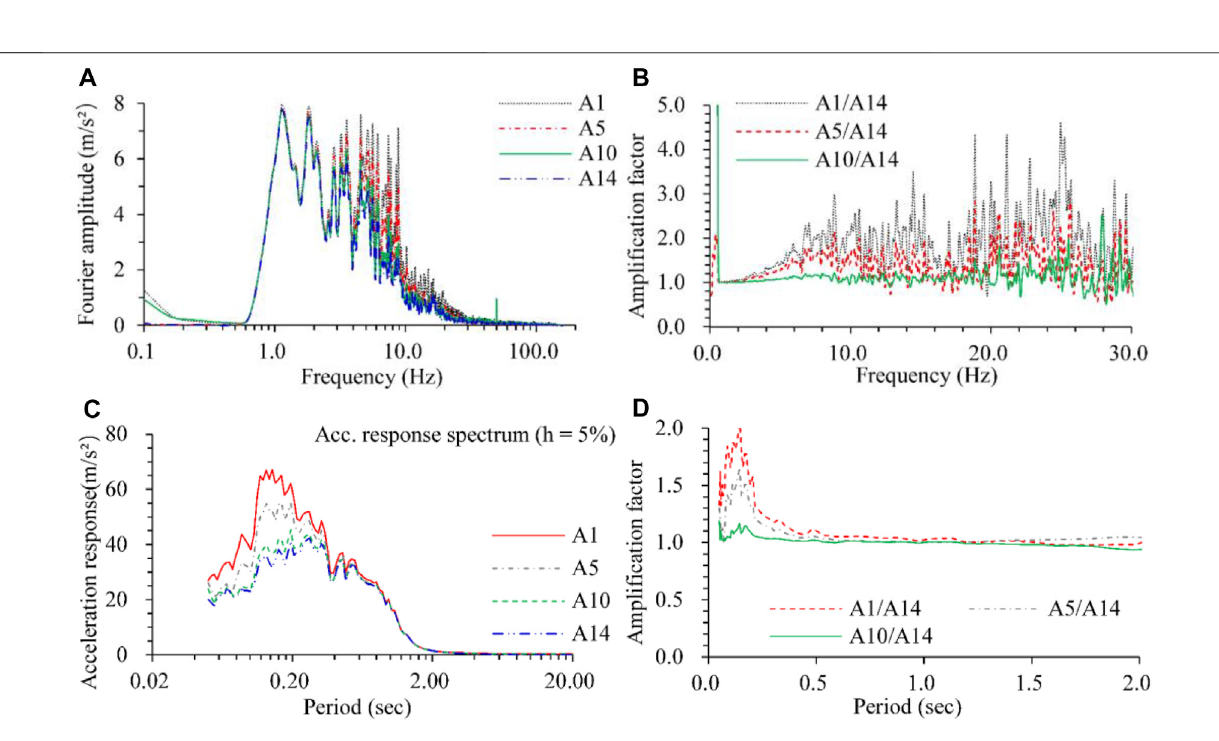
Frontiers in Earth Science |